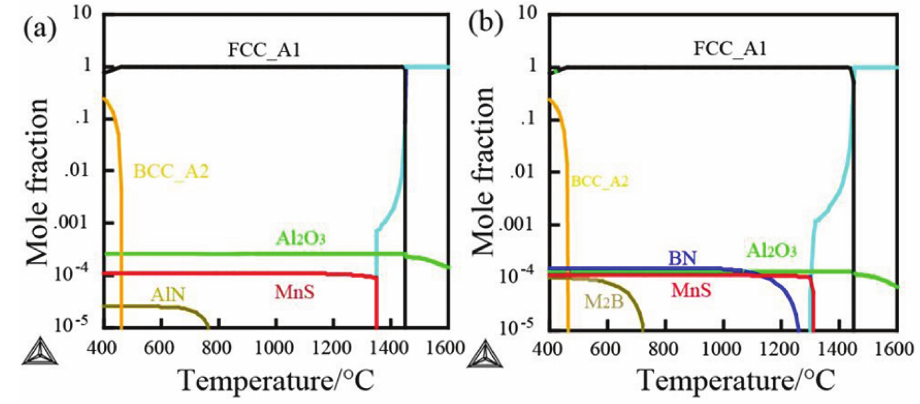
Figure 5: The formation of the secondary phase particles: (a) alloy B0 and (b) alloy B1.